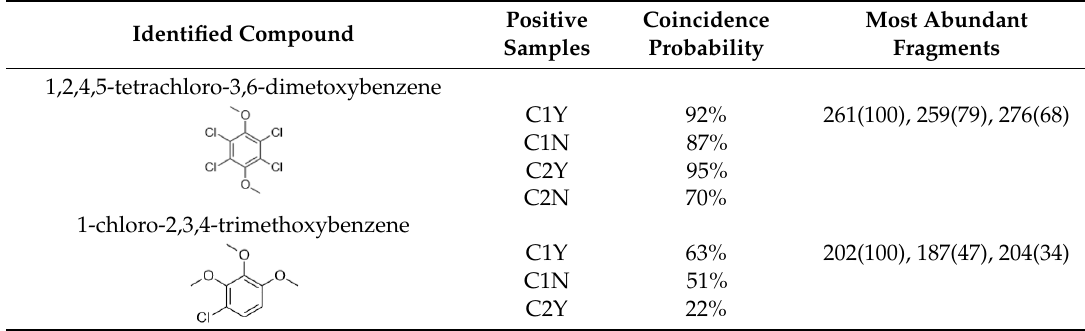
Table 7. Chlorinated compounds identified in cork samples, m / z of the three most abundant fragments with their theoretical relative intensity in brackets and the coincidence probability according to the NIST library. Identified Compound Positive Samples Coincidence Probability